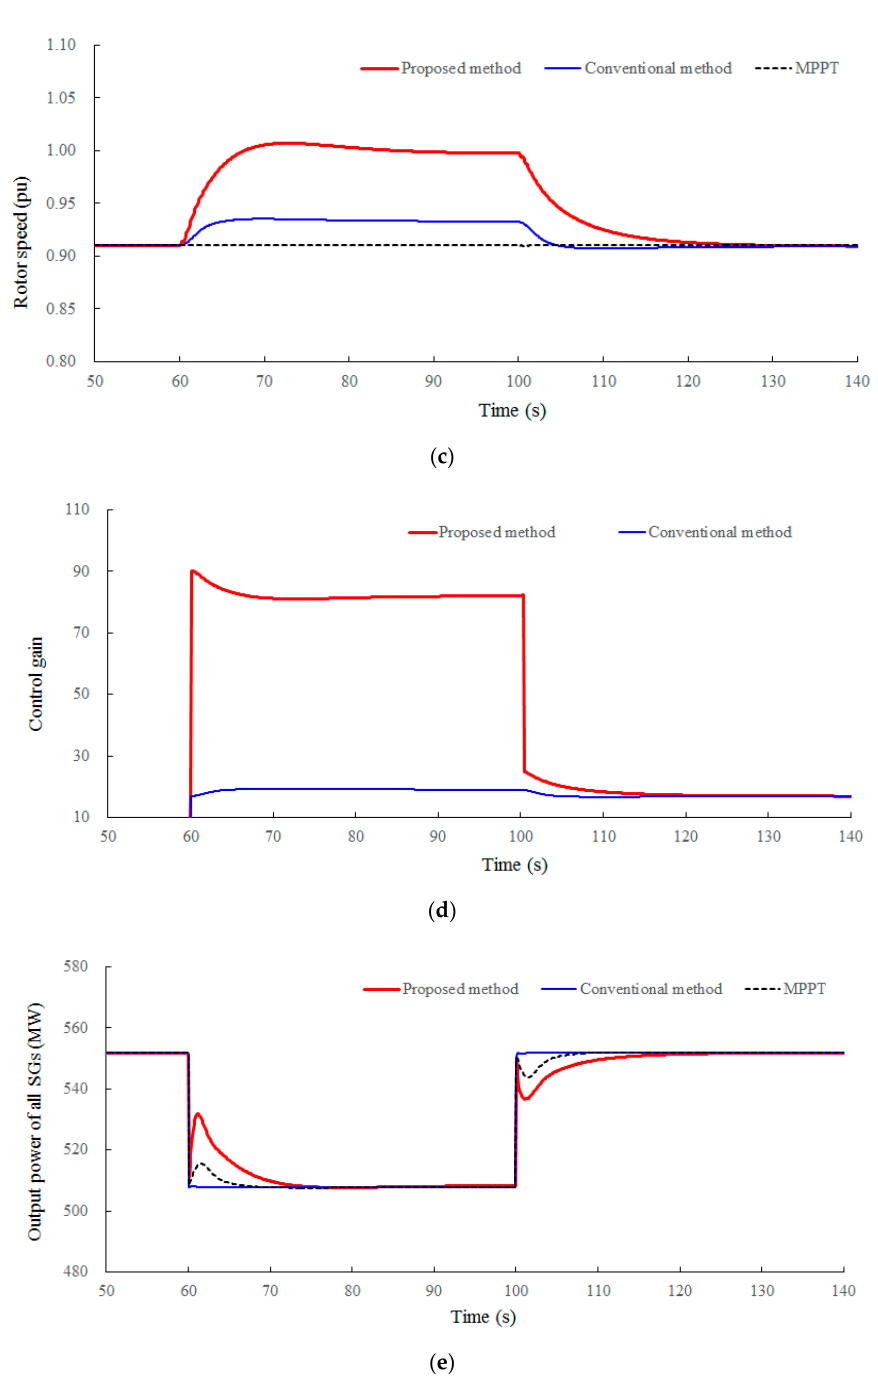
Figure 8. Results for Case 3: ( a ) System frequencies; ( b ) Active powers; ( c ) Rotor speeds; ( d ) Control gain; ( e ) Output power of all synchronous generators.